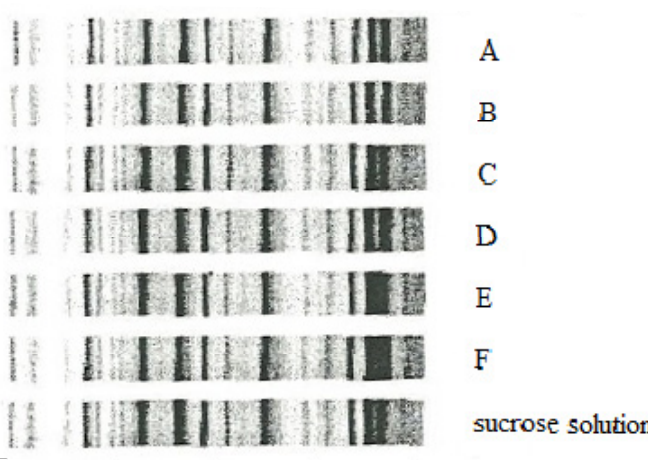
Figure 1. Rep-PCR identified seven isolates with identical banding